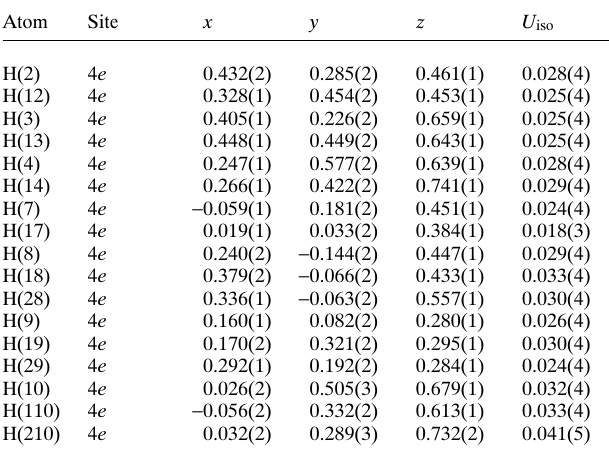
Table 2. Atomic coordinates and displacement parameters (in Å 2 )